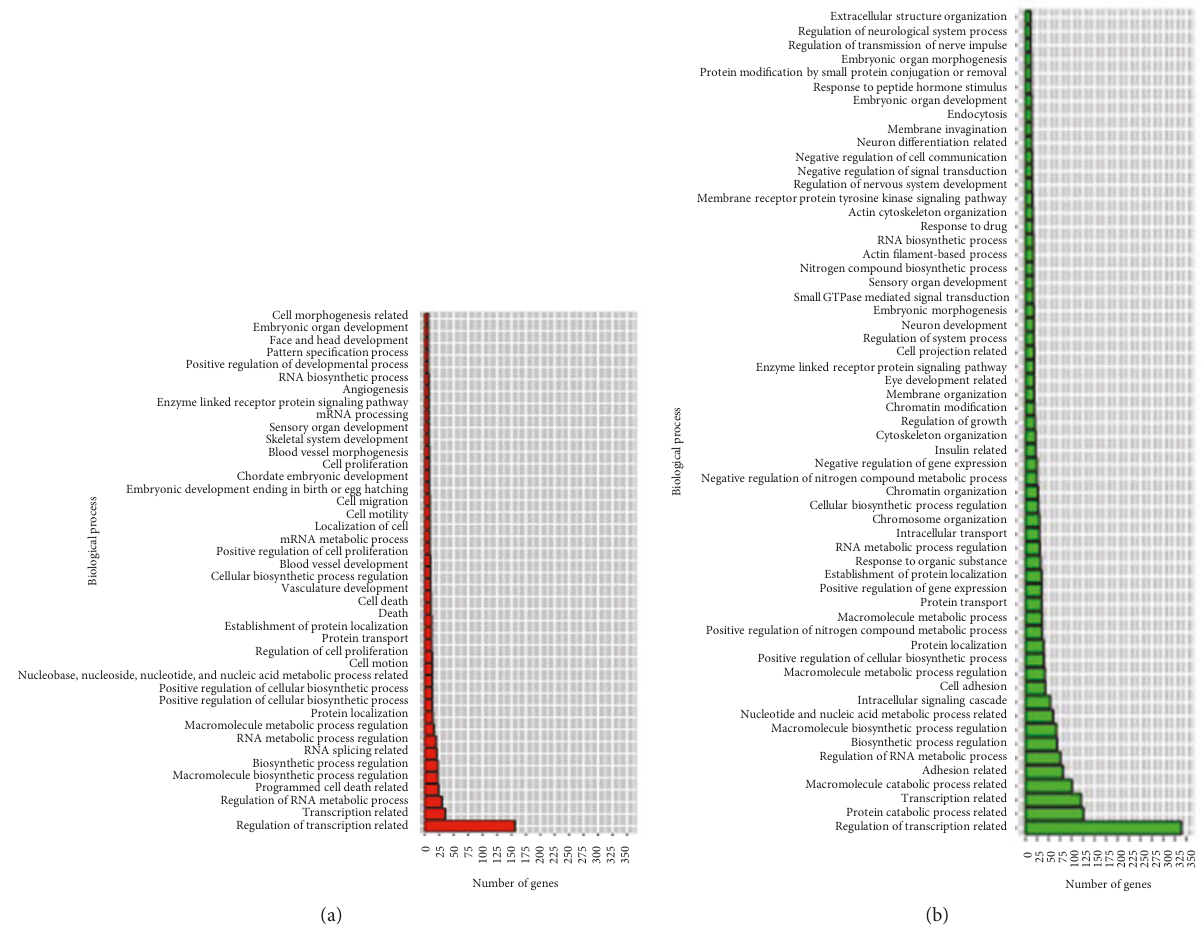
Figure 5: GO terms found for gene targets of di ff erentially expressed miRNAs in response to E. coli exposure in hPBMCs. (a) Upregulated miRNAs; (b) downregulated